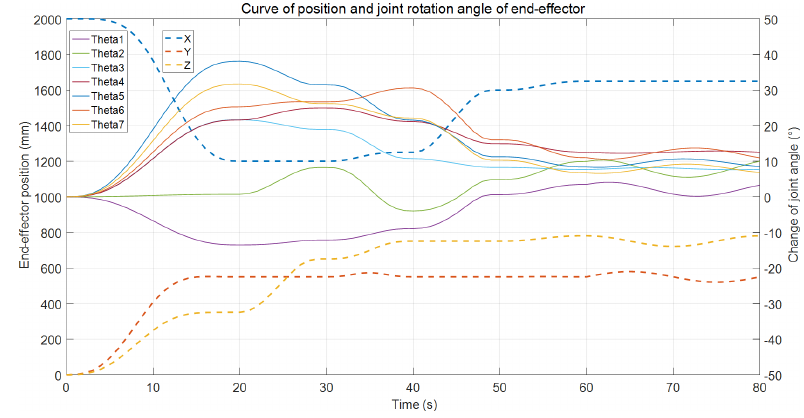
Figure 6. End-effector coordinates and joint angle curves (1).